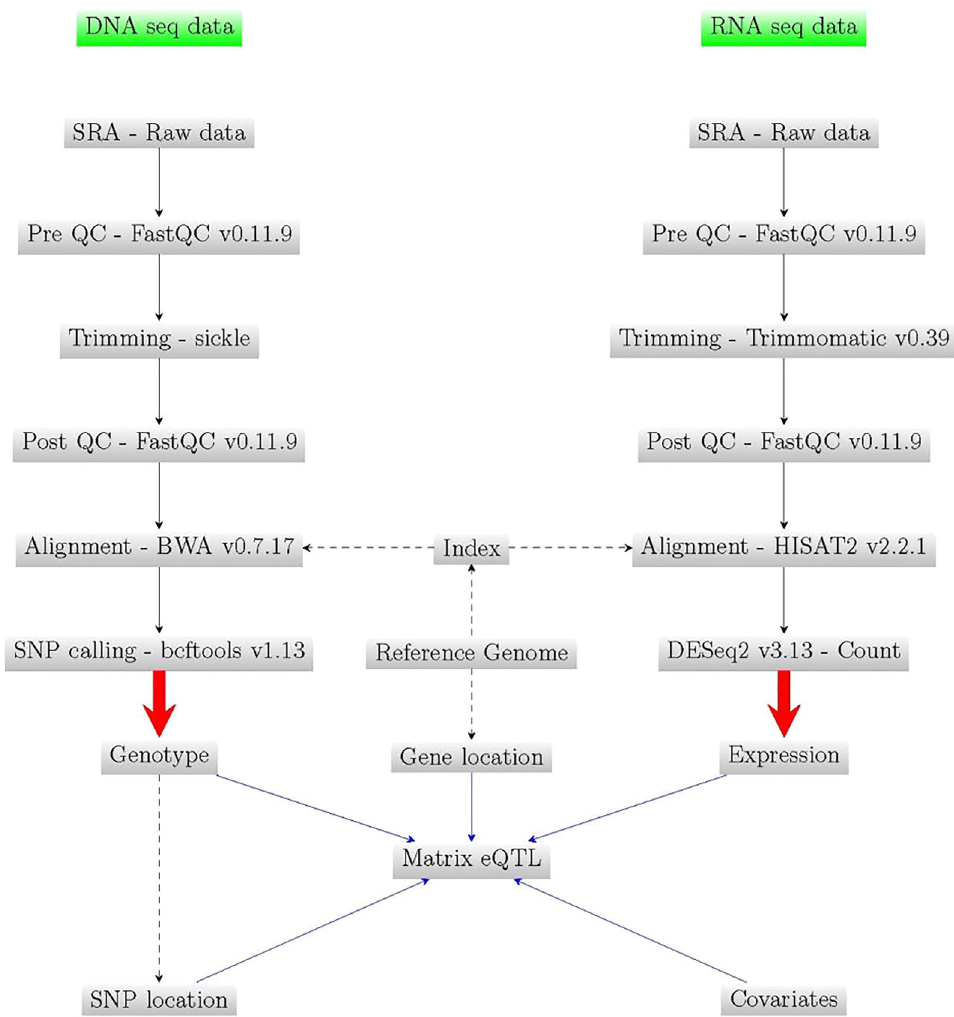
Figure 3. General workflow of the study. The workflow was drawn using the LaTeX package TikZ 53